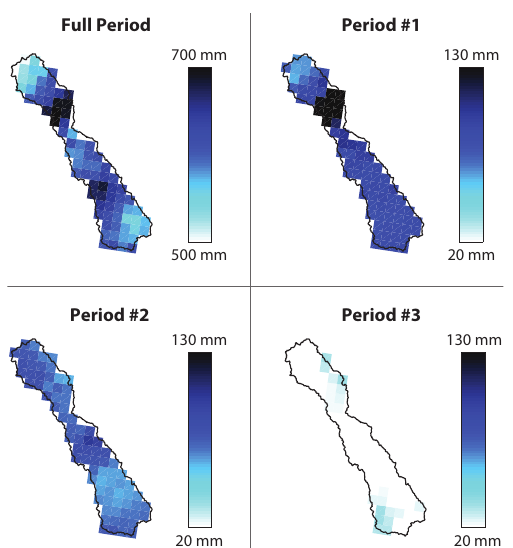
Fig. 3. Maps of precipitation in the Blue River basin over the full six-month simulation period and the three sub-periods defined in Fig. 2. Over the full period, precipitation is roughly even across the watershed. The event during period 1 is focused in the headwaters, while the event during period 2 is more evenly spread. Finally, Period 3 represents a dry period with little streamflow.